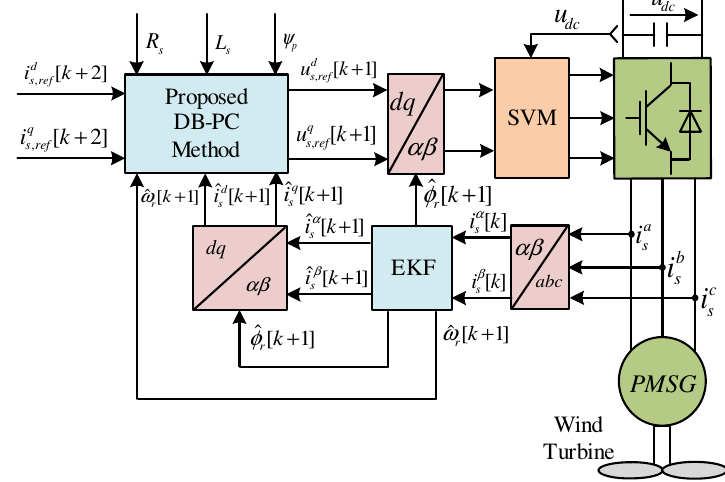
Figure 6. Proposed deadbeat predictive control technique for